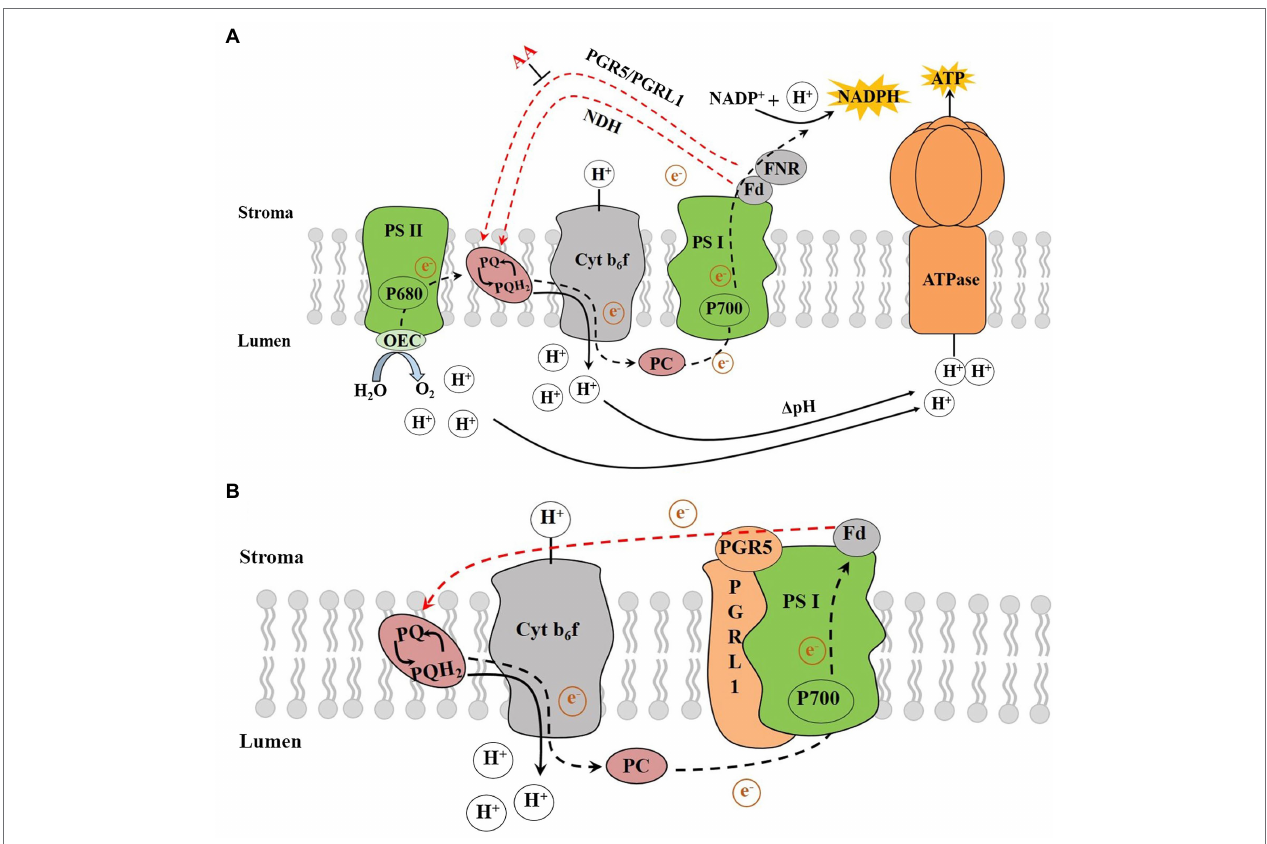
FIGURE 1 | (A) The photosynthetic electron transport chain and (B) The PGR5/PGRL1-dependent CET. AA, antimycin A; ATPase, ATP synthase; Cytb 6 f, cytochrome b 6 f complex; Fd, ferredoxin; FNR, ferredoxin-NADP reductase; Lumen, thylakoid lumen; NADPH, reduced nicotinamide adenine dinucleotide phosphate; NDH, NADH dehydrogenase-like; OEC, oxygen-evolving complex; P680, pigment molecule of PSII reaction centre; P700, pigment molecule of PSI reaction centre; PC, plastocyanin; PGR5, proton gradient regulation 5; PGRL1, PRG5-like photosynthetic phenotype 1; PQ, plastoquinone; PQH 2 , plastoquinol; PSI, photosystem I; PSII, photosystem II, Stroma, thylakoid stroma and Δ pH, proton gradient (adapted from Yamori and Shikanai,